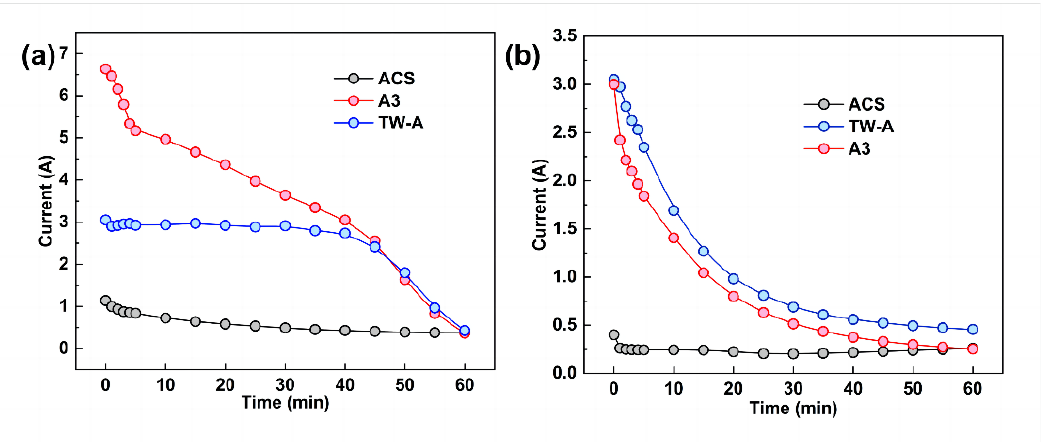
Figure 4. Running current versus time for electrodialysis–metathesis stack tobacco simulant ( a ) under different membranes and tobacco extracts ( b ).